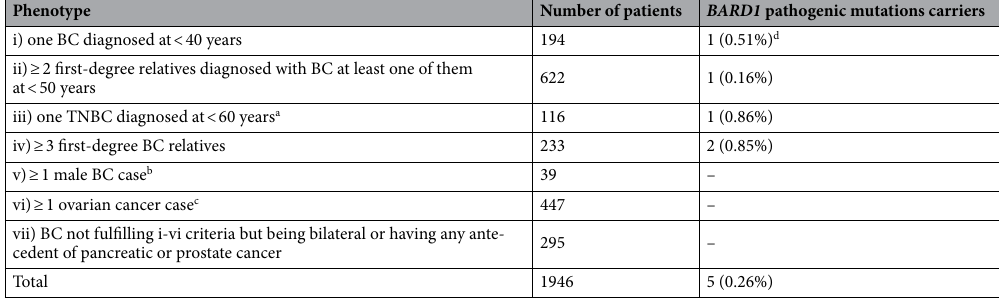
Table 2. Breakdown of the patients included in the study, based on the criteria fulfilled to be screened for pathogenic mutations in BRCA1 and BRCA2 . BC Breast cancer, TNBC Triple negative breast cancer. a includes only patients without familial antecedents of BC or ovarian cancer, TNBC cases fulfilling any of the other criteria (i-vi), were included in the corresponding group, the total number of TNBC in the whole series is 243. b All male breast cancer cases were included in this group, even if they fulfilled any of the other criteria. c All families containing one ovarian cancer case were included in this group, even if they fulfilled any of the other criteria, except those in which there was a case of male breast cancer that were included in group v. d Number and percentage of patients carrying pathogenic BARD1 mutations in each phenotypic